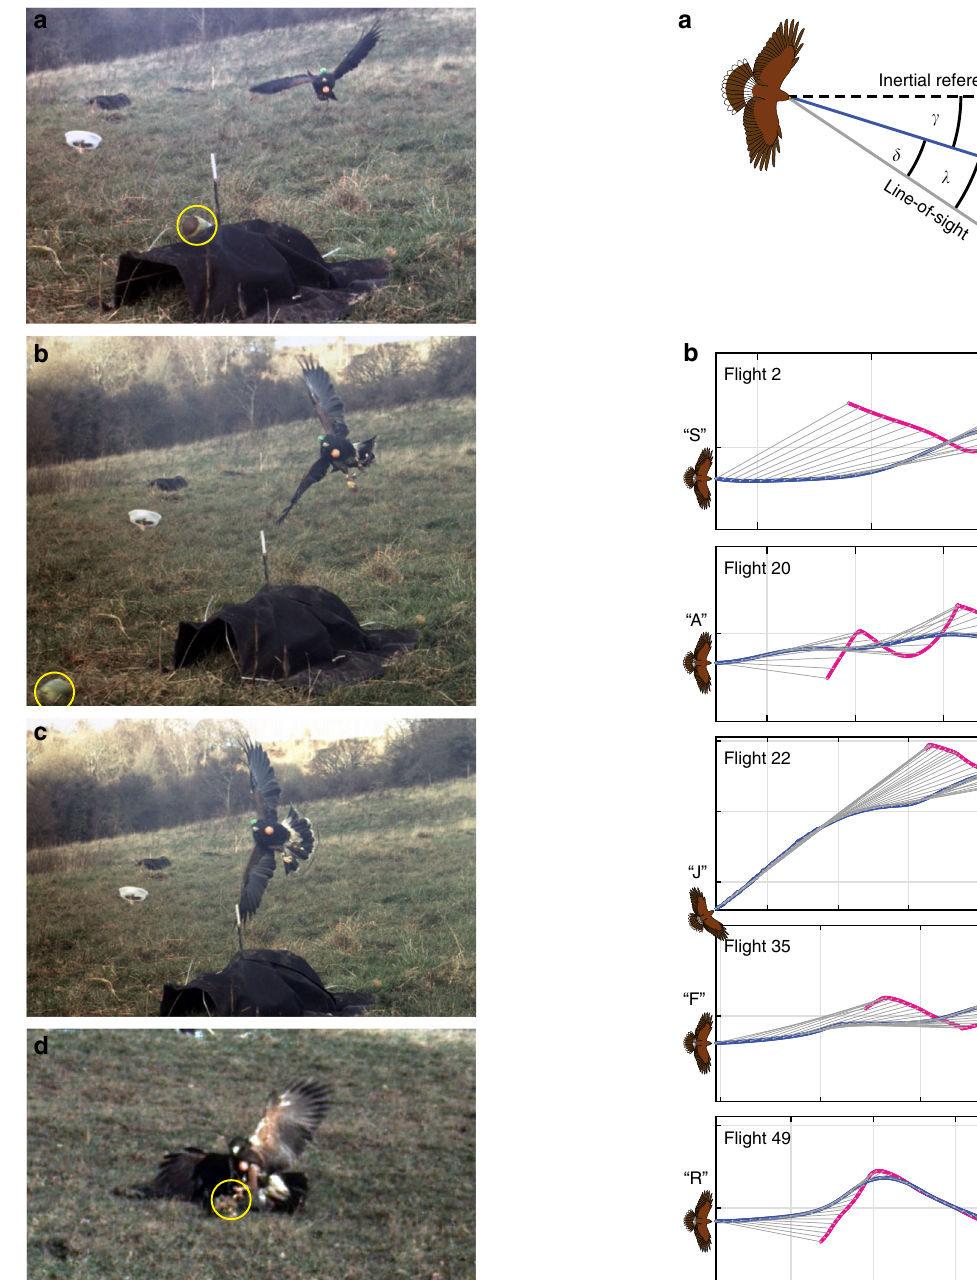
Fig. 1 Sequence of video frames from a representative attack. Five captive Harris ’ Hawks chased a lure pulled at speed around a randomised zigzagging course of pulleys and tunnels. a Hawk initiating banked turn, with its inside wing pitched down and its outside wing pitched up; b hawk at a high bank angle 0.25 s later, with its head held such that the eyes are approximately level; c hawk fully banked another 0.05 s later, with its head still held with the eyes approximately level; d hawk captures lure with one foot. Lure is circled yellow if visible